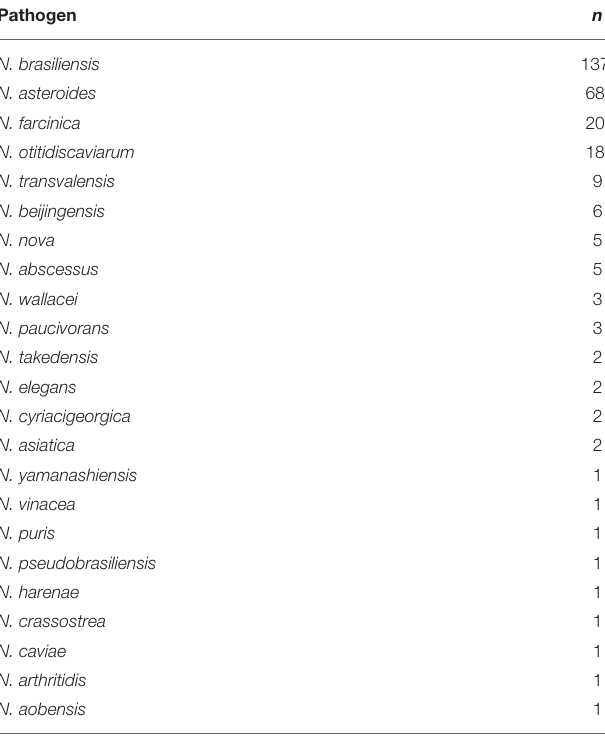
TABLE 3 | Count of the different Nocardia species identified in patients with isolated nocardiosis. Pathogen